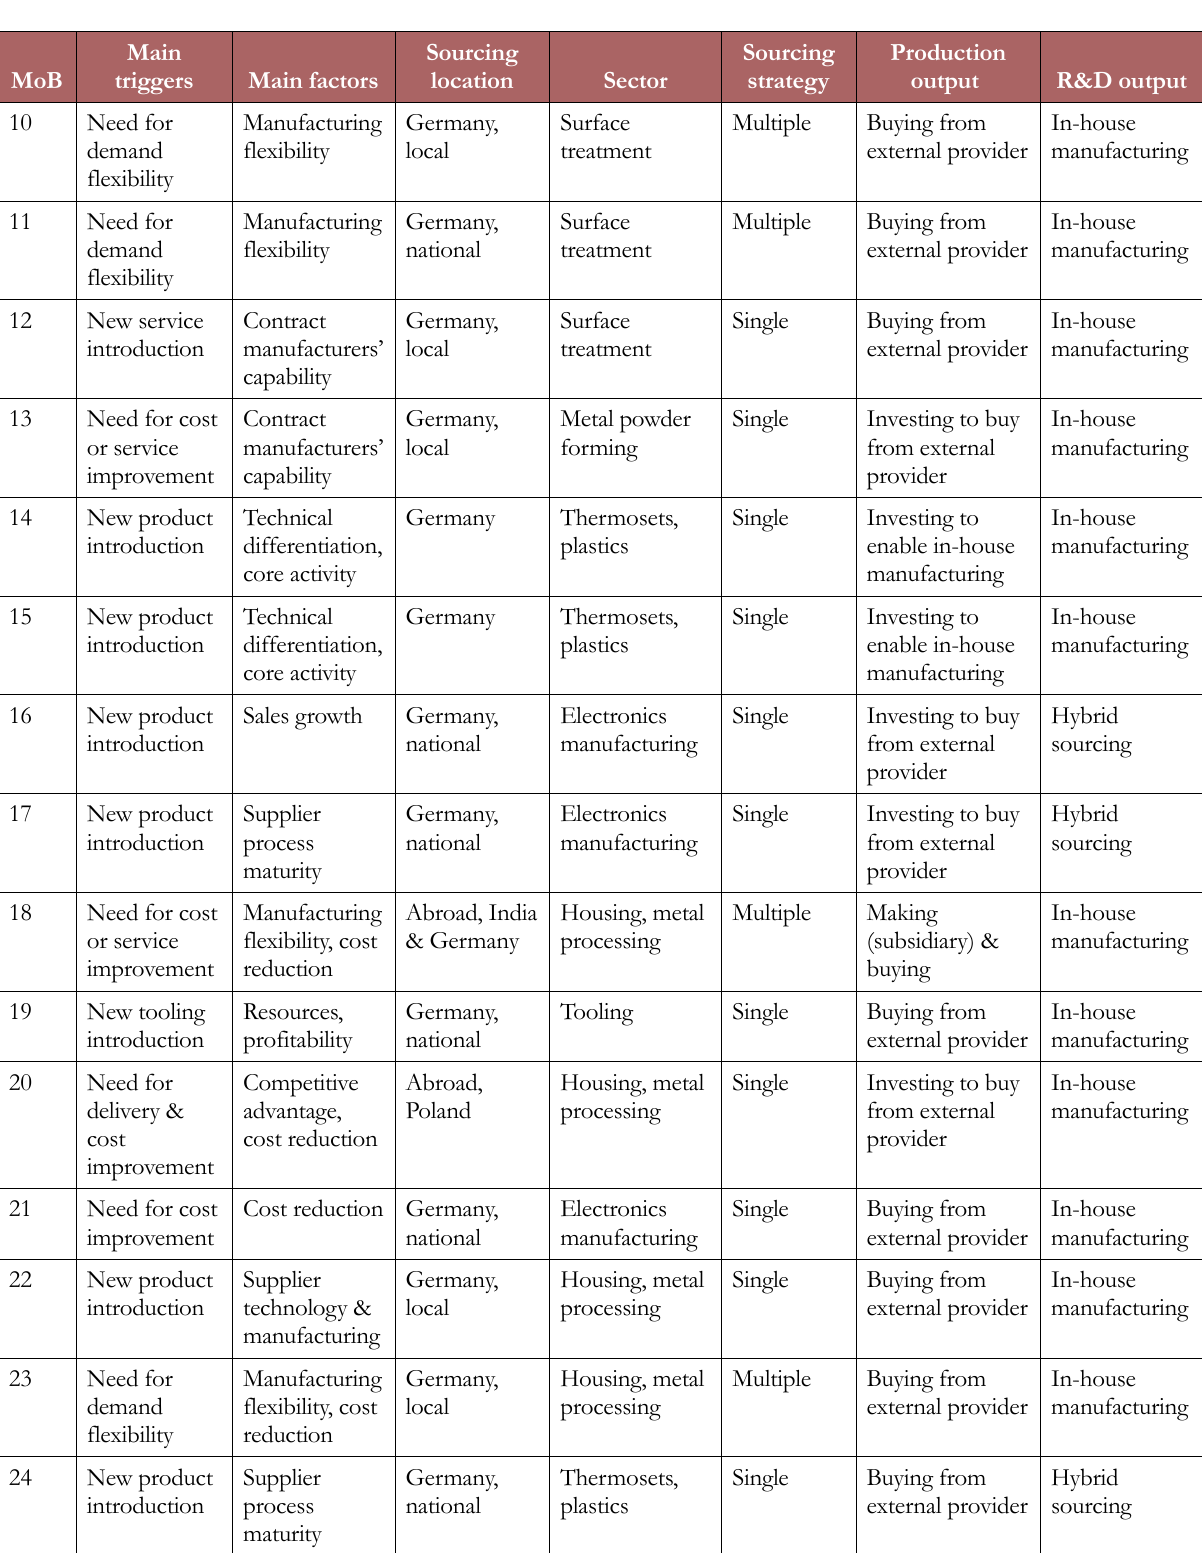
Table 2. MoB decisions. Summarised outputs, case